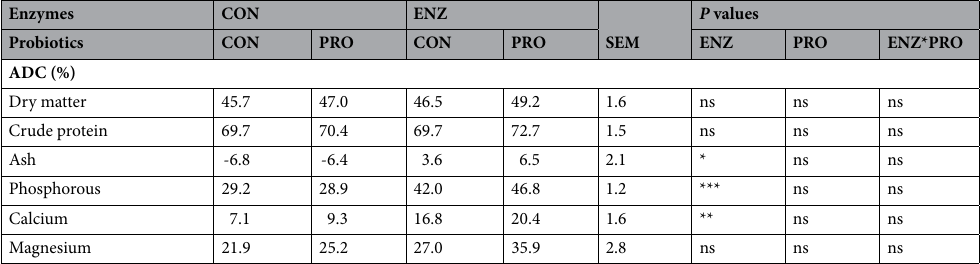
Table 3. The apparent digestibility coefficient (ADC %) in the distal gut of Nile tilapia, values for stomach, proximal and middle are given in Supplementary Table S1. CON; no supplementation; ENZ, enzyme (effect) supplementation; PRO, probiotic (effect) supplementation; ENZ*PRO, interaction effect; SEM, standard error of means; ns, not significant, * P < 0.05, ** P < 0.01, *** P < 0.001.